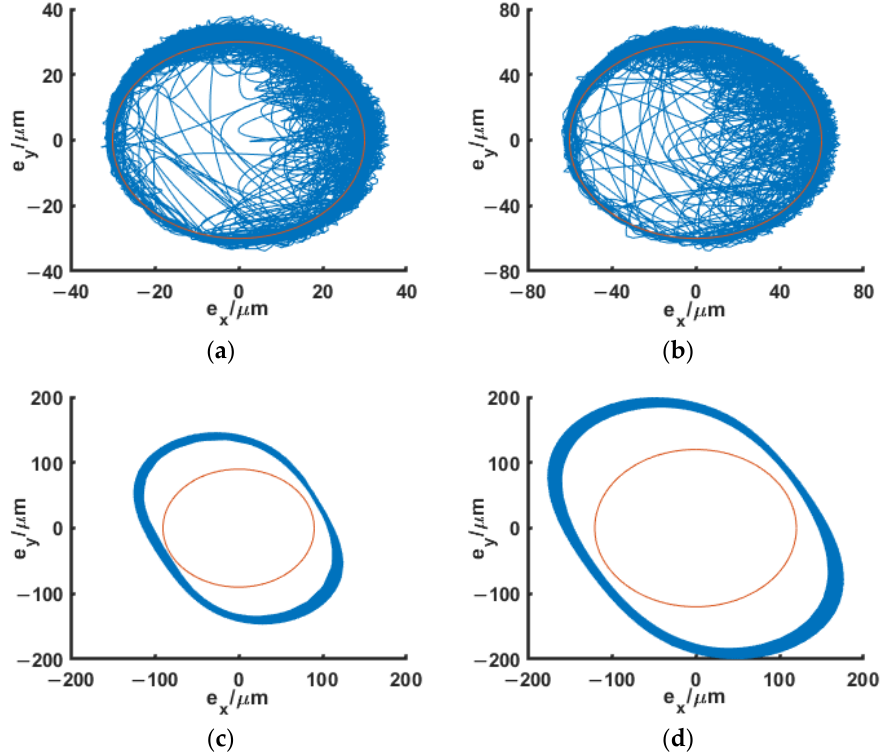
Figure 11. Axis trajectory of shaft at different clearance sizes. ( a ) r = 0.03. ( b ) r = 0.06. ( c ) r = 0.09.